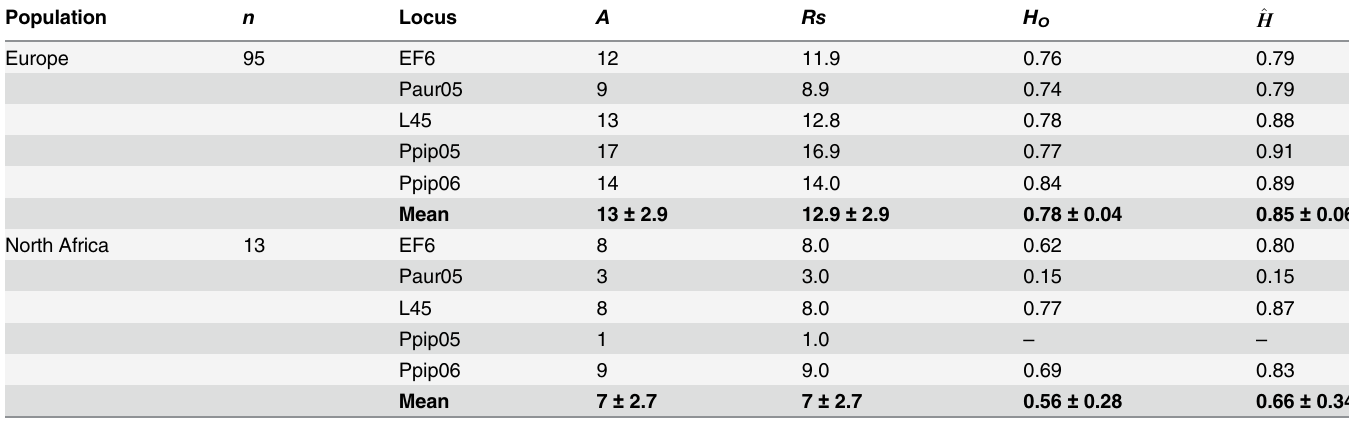
Table 1. Standard diversity indices calculated for five microsatellite loci genotyped in two subpopulations of P . kuhlii . Population n Locus A Rs H O ^ H Europe 95